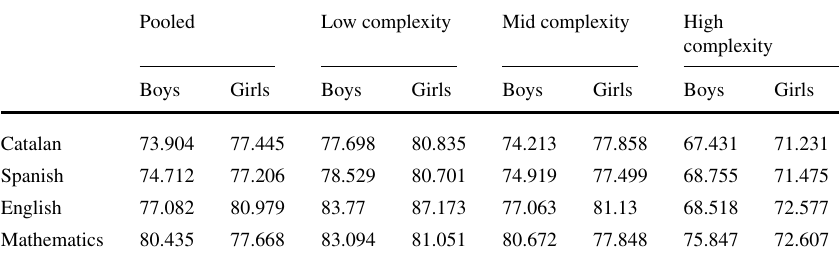
Table 6 Average grades by gender and school complexity